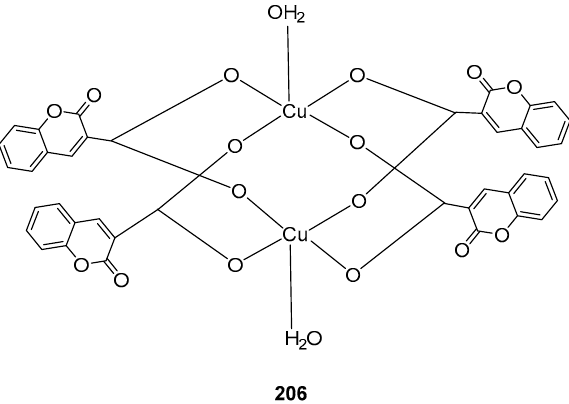
Figure 68. Chemical structure of coumarin-3-carboxilate-copper (II) complex ( 206 ).